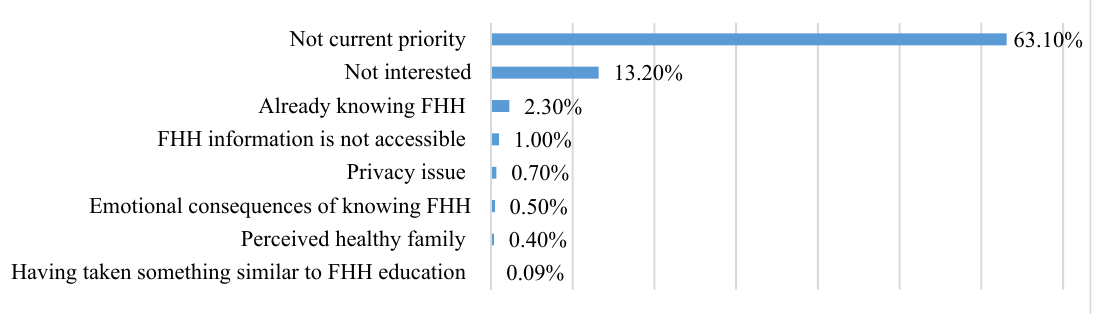
Figure 1. Reasons for not being interested in receiving FHH education ( n = 1226). FHH: family health history.